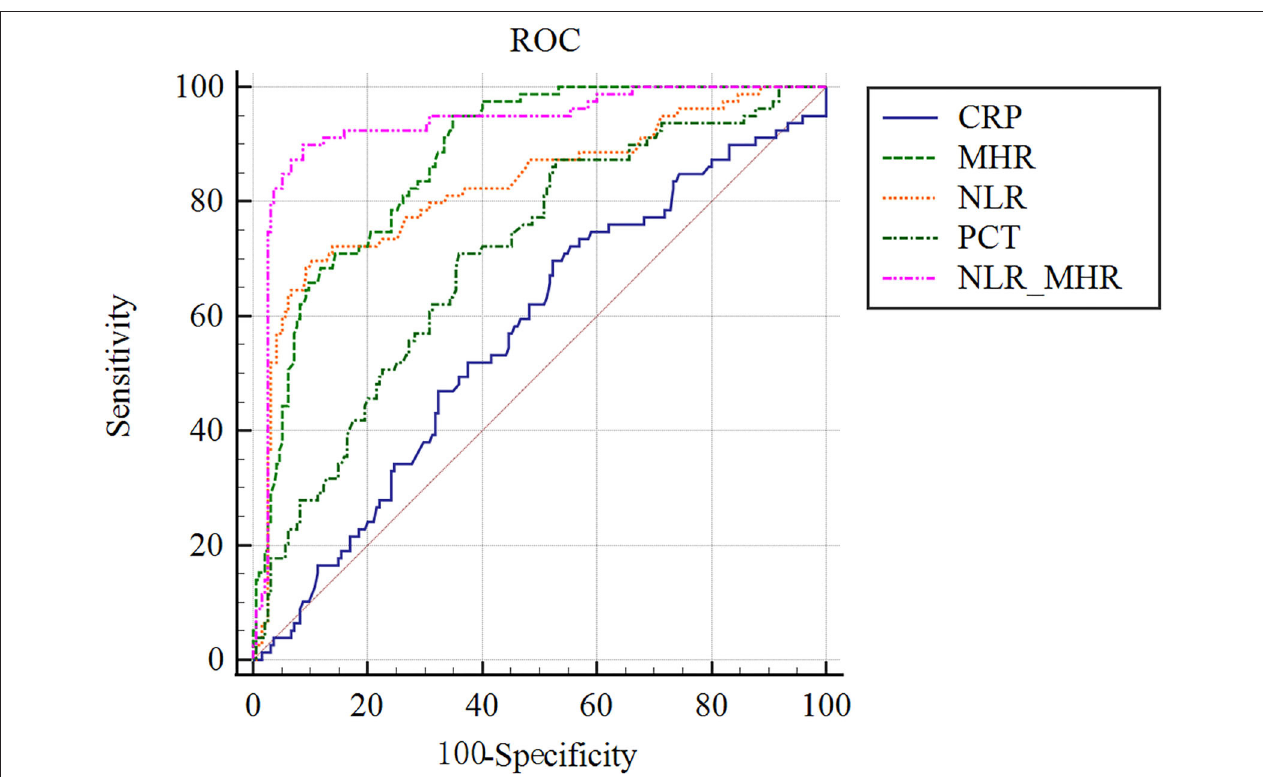
FIGURE 3 | ROC analysis of parameters for predicting the prognosis of 28-day mortality in sepsis. MHR_NLR model displayed the largest AUC than other indicators. The AUC value of CRP was found to be the minimum, which were talentless in predicting sepsis prognostic risk.